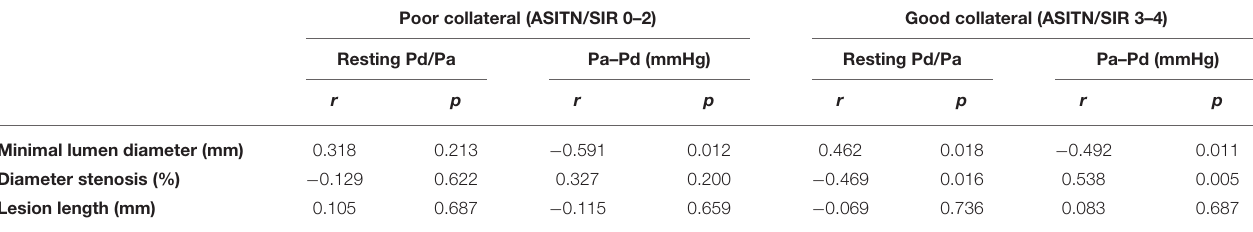
TABLE 3 | Correlation between pressure-derived and angiography-derived indices based on collateral